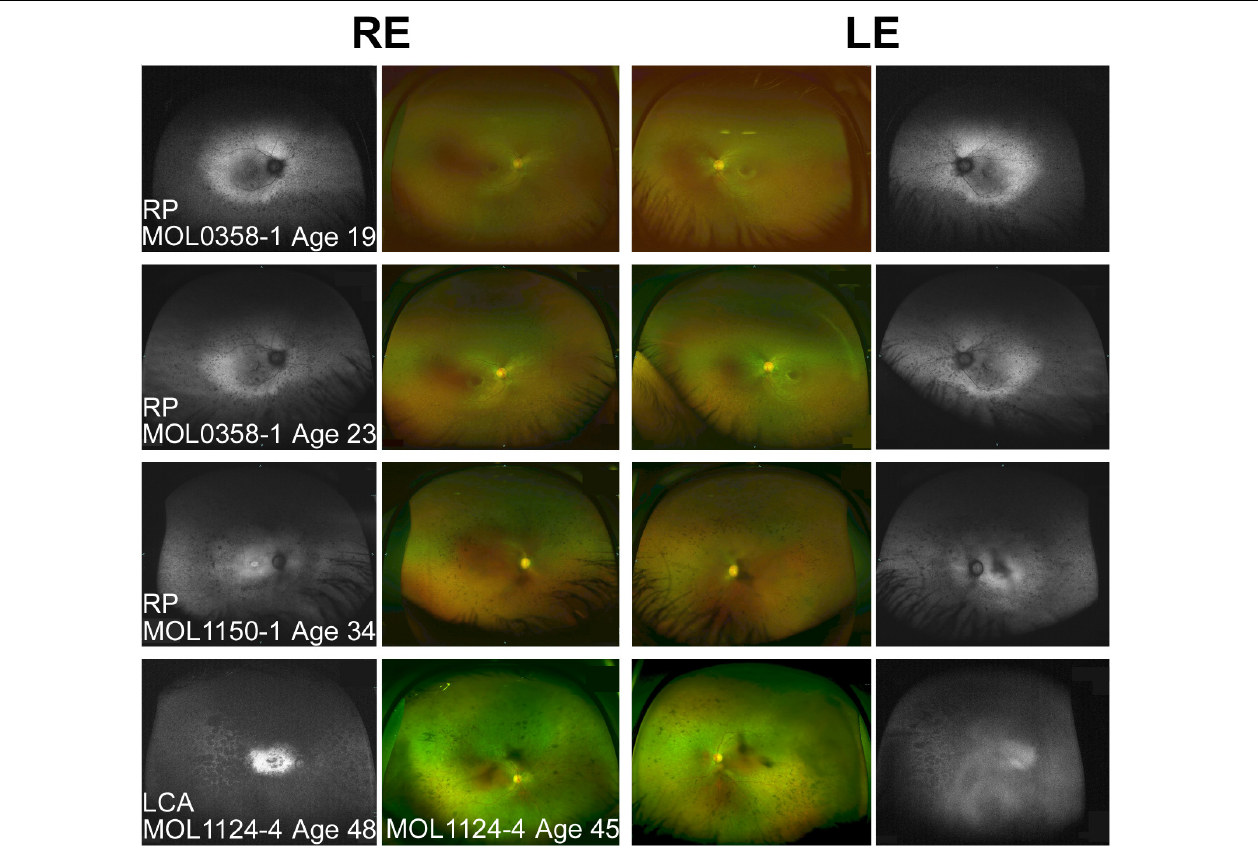
FIGURE 3 | Spectrum of fundus findings among RPGRIP1 patients from our cohort at different ages. Wide field OPTOS pseudocolor and fundus autofluorescence (FAF) images show that bone spicule-like pigmentary changes appear at teen years. In older patients (ages 30+), nummular pigmentation was also observed. Diagnosis, patient numbers, and the age at the time of imaging are specified on each of the panels. FAF images of MOL1124-4 from the age of 45 were not available because of technical problems, and FAF images at the age of 48 are shown instead. The FAF image of the left eye of this patient is partially obscured because of